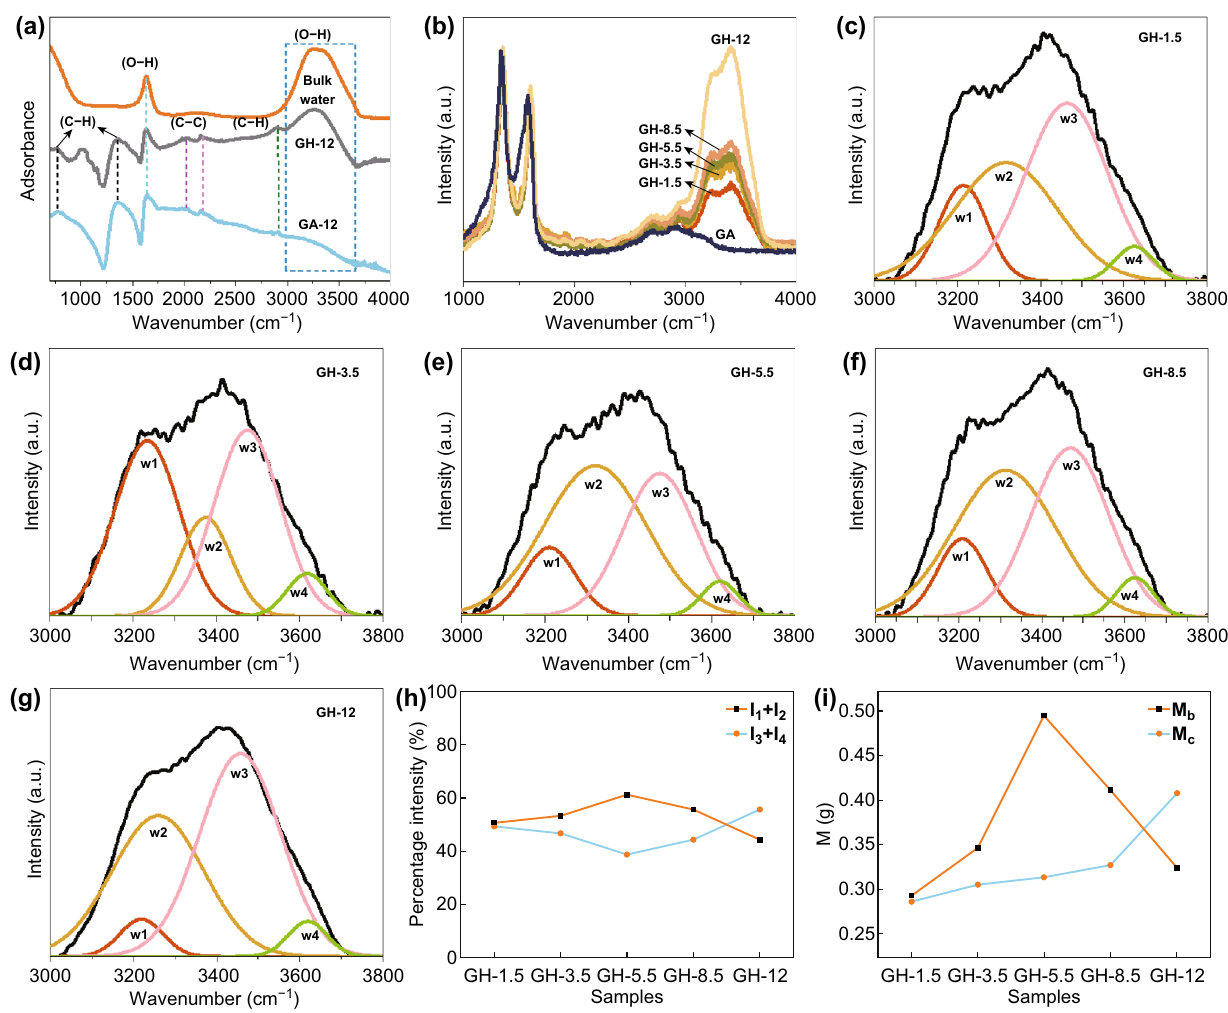
Fig. 5 a ATR-IR spectra for bulk water, GH-12, and GA-12; b Raman spectra of the GA and GH samples; c – g OH stretching sub-band of water in the GH samples; h percentage intensity of w 1 + w 2 ( I 1 + I 2 ) and w 3 + w 4 ( I 3 + I 4 ) in the GH samples; and i mass of bulk water ( M b ) and confined water ( M c ) in the GH